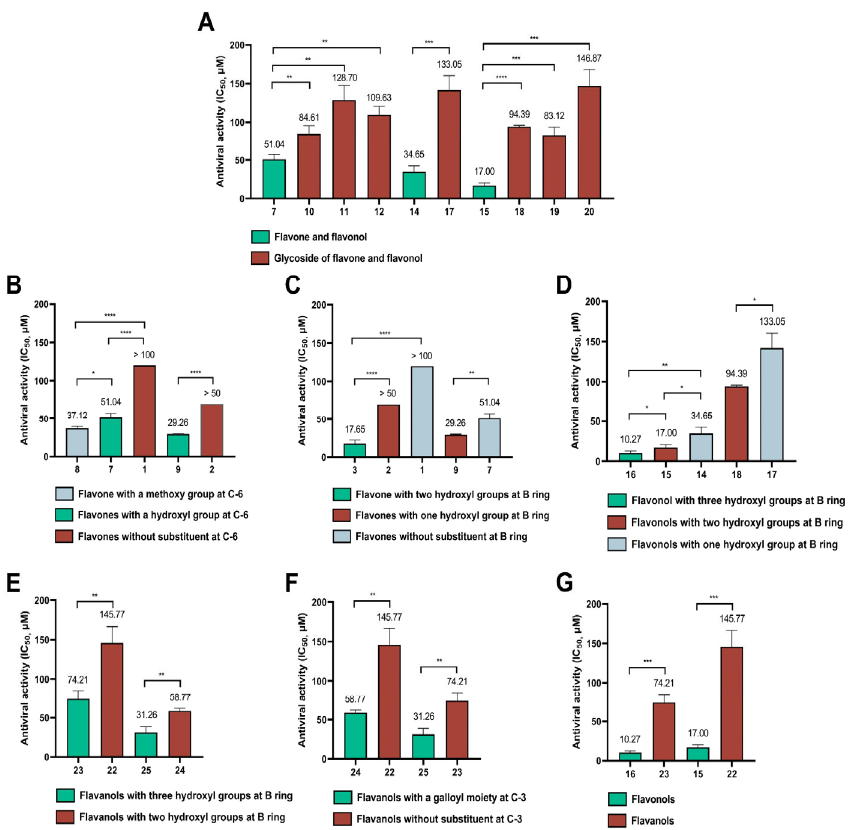
Figure 2. Comparison of inhibitory activity of flavonoids against SARS-CoV-2 pseudovirus entry into host cells. ( A ) Effect of glycosyl moieties on flavonoids; ( B ) Effect of a hydroxyl or methoxy group at C-6 on flavones; ( C ) Impact of the number of hydroxyl groups at B ring on flavones; ( D ) Impact of the number of hydroxyl groups at B ring on flavonols; ( E ) Impact of the number of hydroxyl groups at B ring on flavanols; ( F ) Effect of a galloyl moiety at C-3 on flavanols; ( G ) Effect of a planar C ring of flavonols compared to a stereo C ring of flavanols. Data were obtained from three separate experiments. * p < 0.05, ** p < 0.01, *** p < 0.001, **** p <